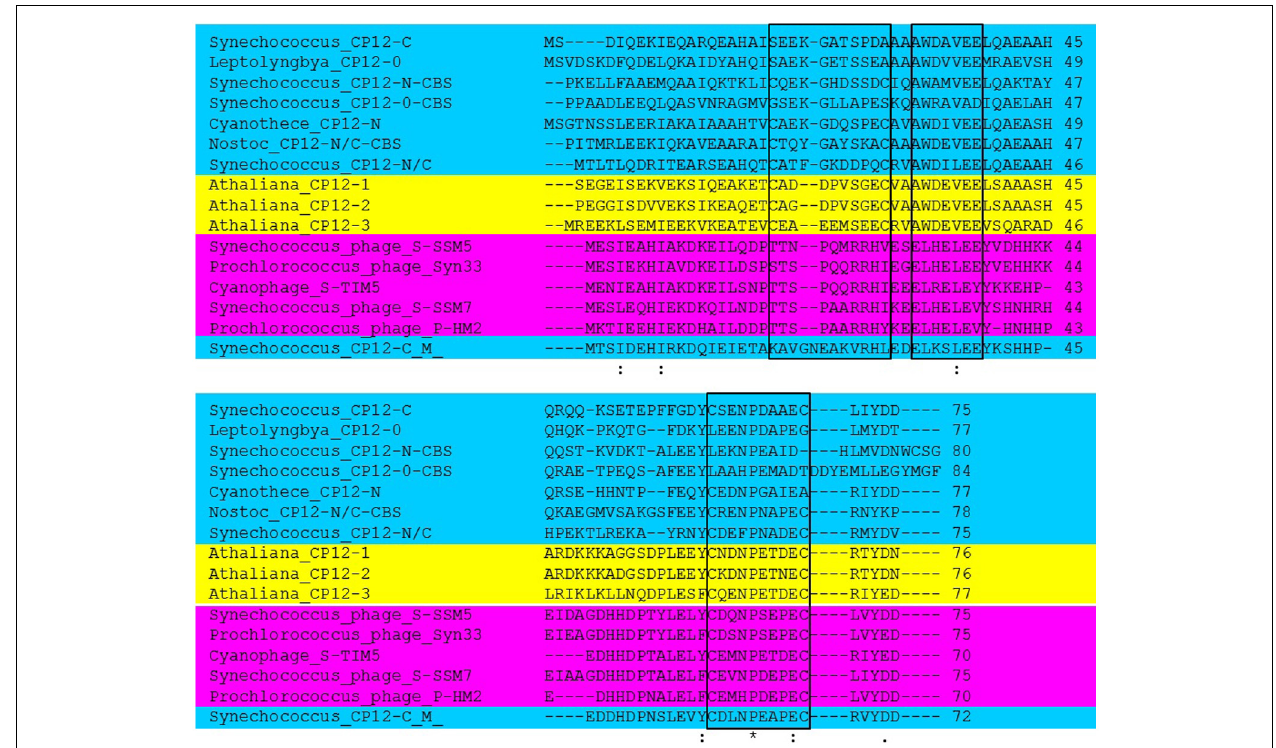
for Cyanophages:YP_004324623.1 ( Synechococcus phage S-SSM5), YP_004323628.1 ( Prochlorococcus phage Syn33),YP_007006052.1 (Cyanophage S-TIM5),YP_004324068.1 ( Synechococcus phage S-SSM7), and YP_004323596.1 ( Prochlorococcus phage P-HM2). Cyanobacterial